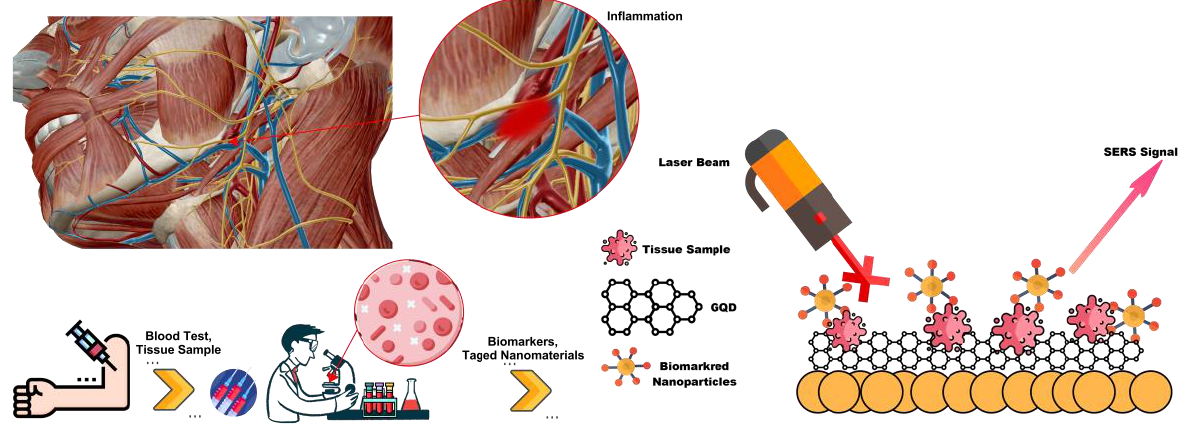
Figure 8. Detection of inflammatory by SERS-enhanced GQDs.